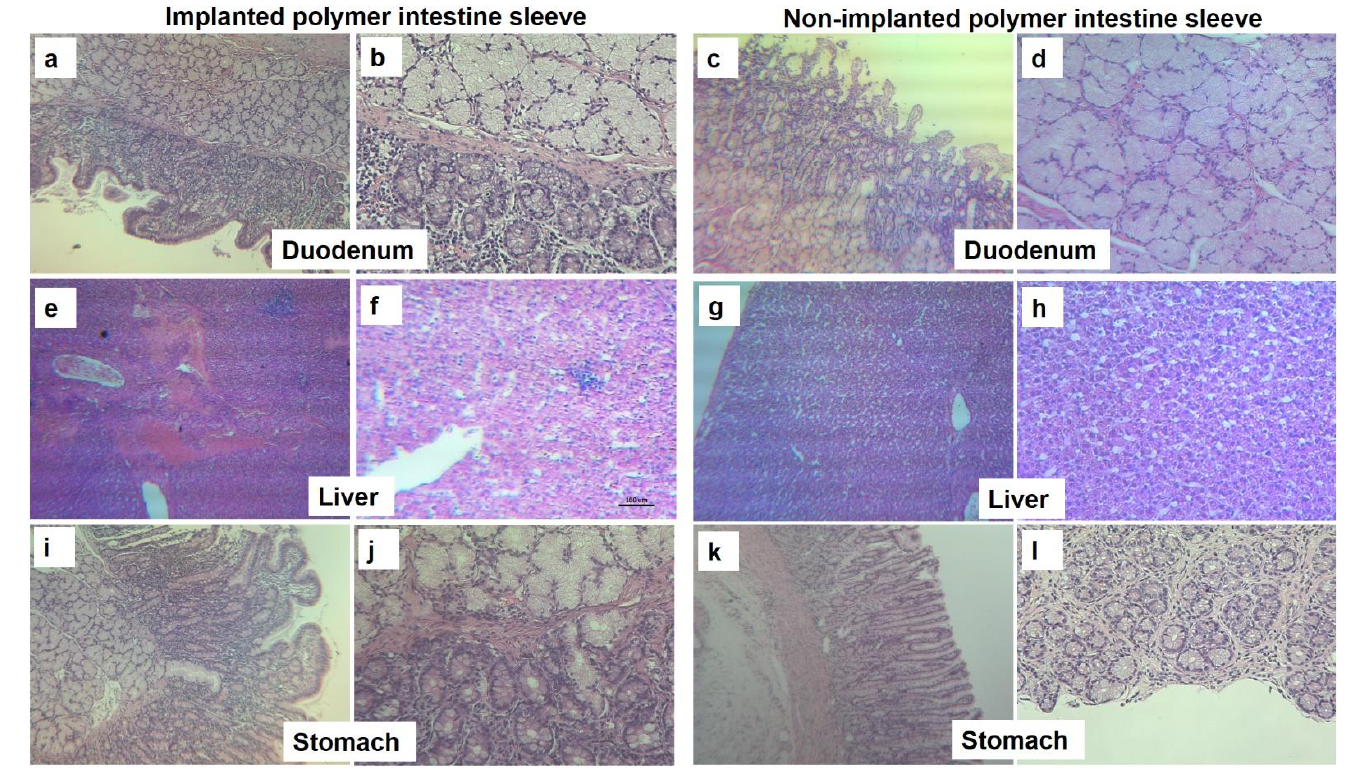
Figure 8. The H&E-stained tissue sections for various implanted tissues. Polymer intestinal sleeve implanted in the duodenum ( a , b ) and control duodenum ( c , d ); polymer intestinal sleeve implanted in liver tissue ( e , f ) and control liver tissue ( g , h ); polymer intestinal sleeve implanted in stomach tissue ( i , j ) and control stomach tissue ( k , l ). Magnification, ×40 in ( a , c , e , g , i , k ) and ×100 in ( b , d , f , h , j , l ).